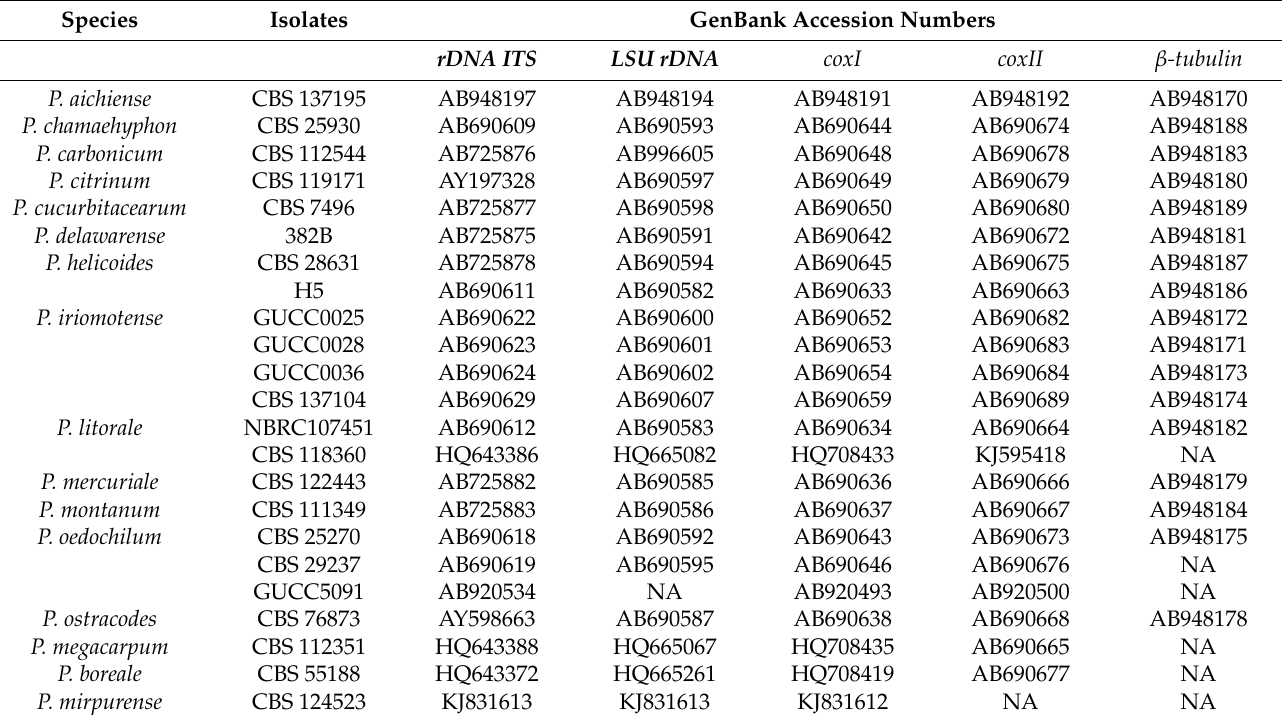
Table 3. GenBank accession numbers of isolates used for phylogenetic analysis in this